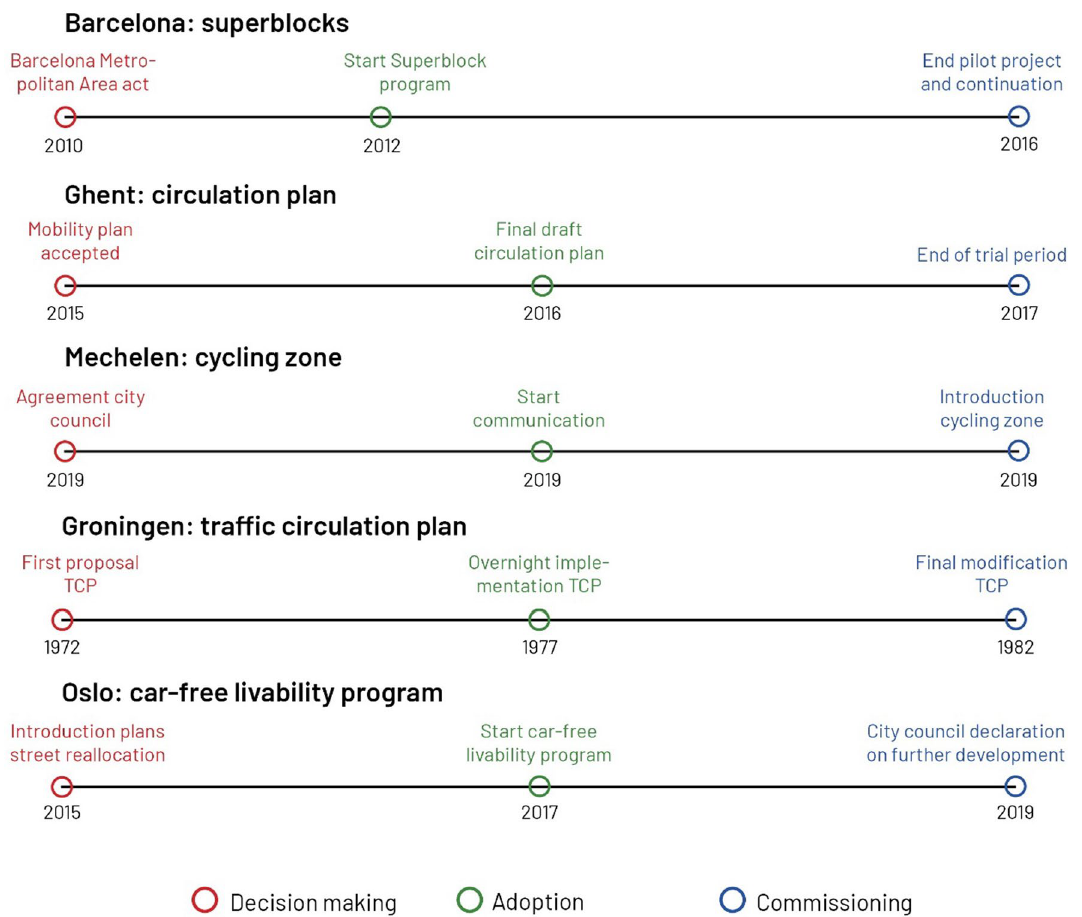
Fig. 6 Representation of case studies’ timeline and main events for the decision-making, adoption and commissioning gates (primarily spatial